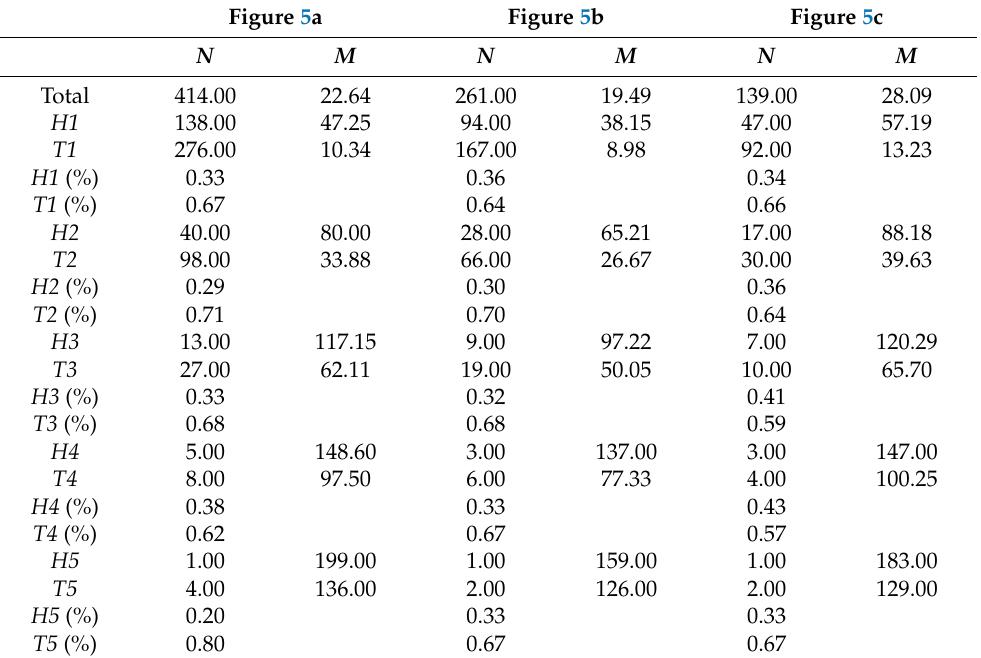
Table 1. Head/tail break data from Figure 5 (where N is the number, M is the average, Hi ( i = 1,2,3,4,5) is the head of the i th breaking, and Ti ( i = 1,2,3,4,5) is the tail of the i th